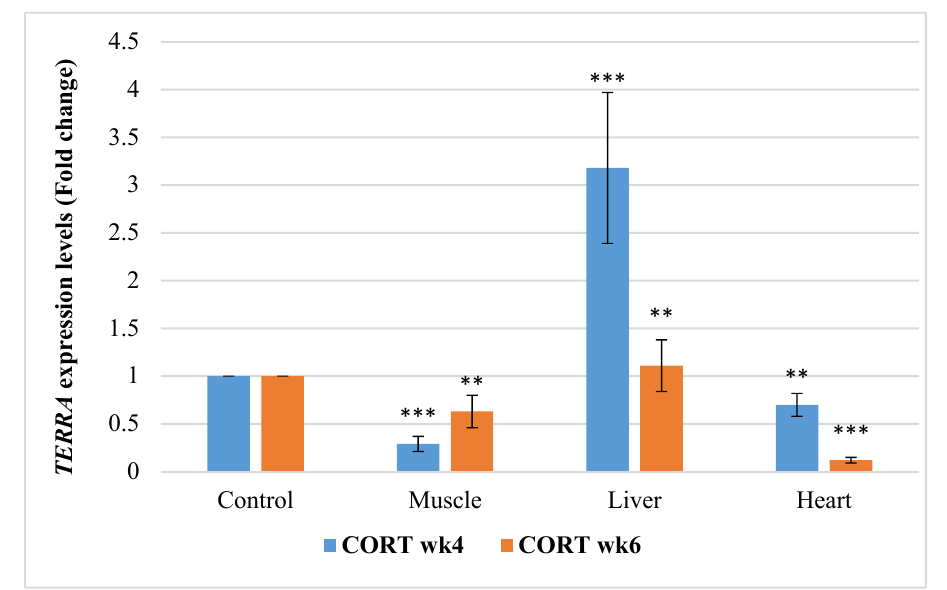
Figure 4. Expression profile of telomeric repeat-containing RNA ( TERRA ) in the muscle, liver, and heart at week 4 and 6 of corticosterone-fed chickens compared to the control (fold change). CORT wk4 = 4 weeks of age (2 weeks of CORT administration); CORT wk6 = 6 weeks of age (4 weeks of CORT administration); n = 20. Probability, ** = p < 0.01; *** = p <